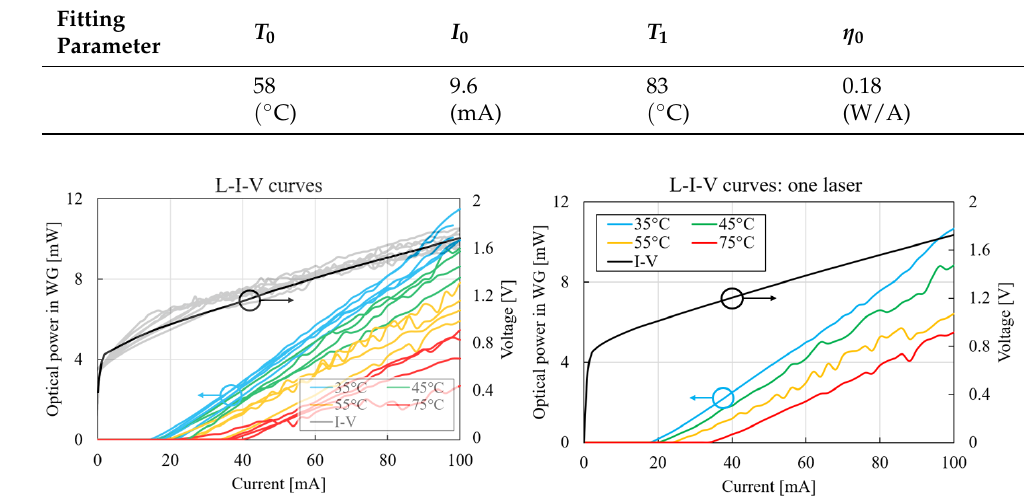
Figure 2. Laser L–I–V characteristics with increasing temperature as parameter ( T = 35 ◦ C:75 ◦ C). The I–V curve was taken at T = 25 ◦ C and showed no significant temperature dependence.